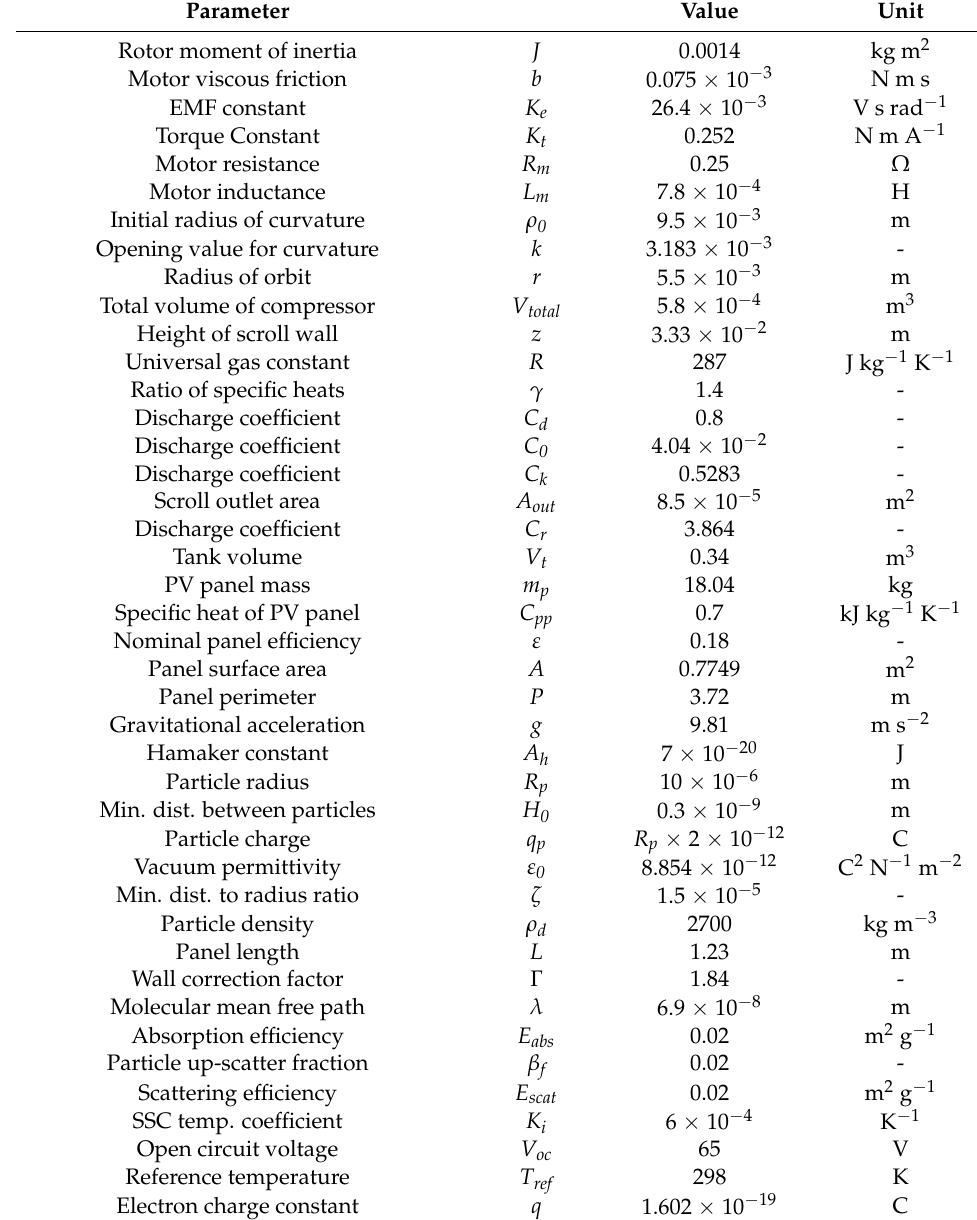
Table A1. Parameters used for simulation and